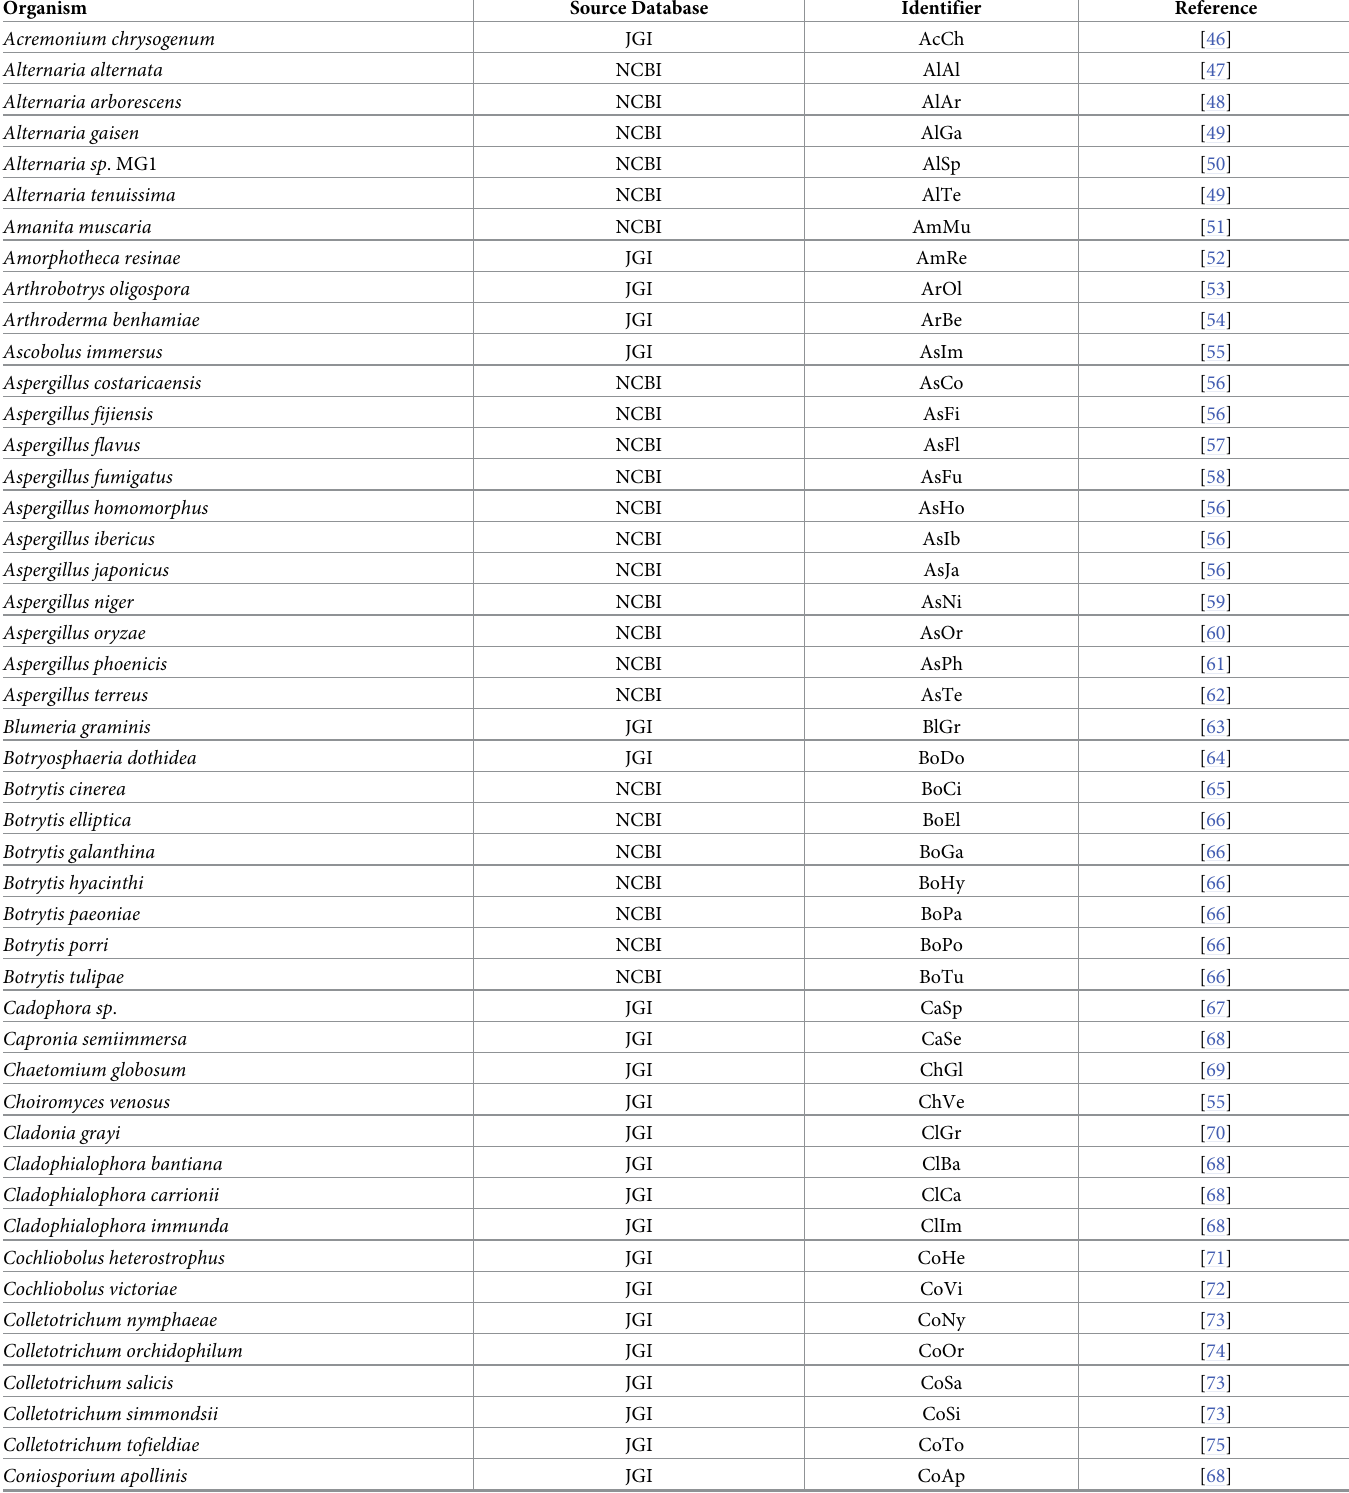
Table 1. Fungal proteomes included in the empirically optimized